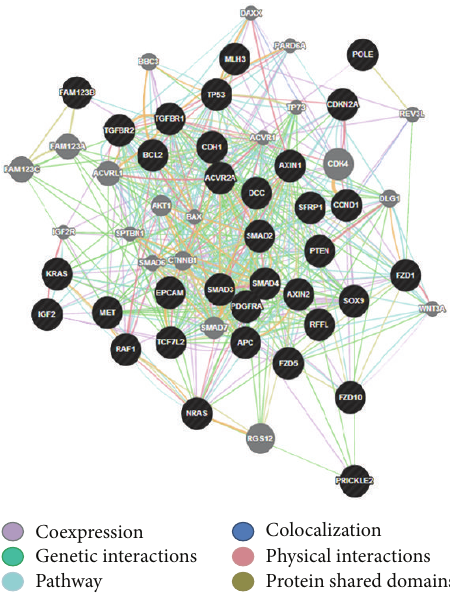
Figure 4: This is a representation of all 34 genes that were initially selected as major contributors to colorectal cancer and how they are related to each other in terms of pathways, colocalization, coexpres- sion, shared protein domains, predicted genes, and physical and genetic